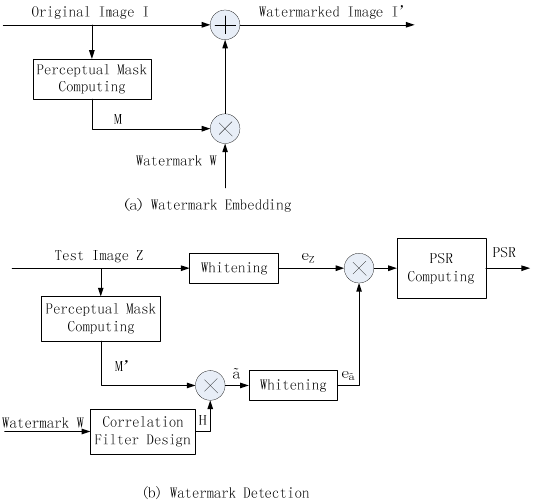
Figure 1. The diagram of the proposed scheme In the watermark detection, Similar to the embedding procedure, the perceptual mask M ’ is computed according to the input test image Z . Z is whitened before correlation. A specific correlation filter H (either OTCHF filter or MACE-MRH filter) is designed with the watermark W as the reference pattern. The correlation filter can provide a user-specified response to in-plane rotation or scale distortion. Thus the watermark detection based on correlation is robust to the specified rotation or scale